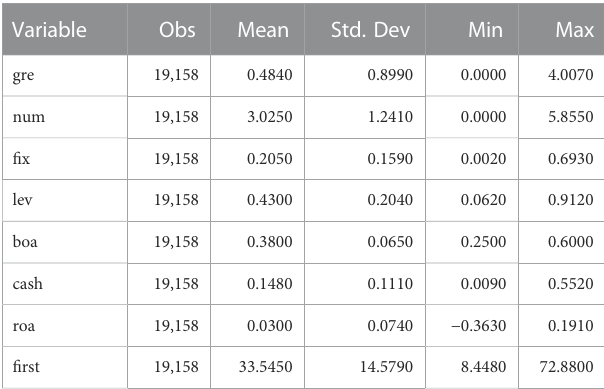
TABLE 2 Descriptive statistics.